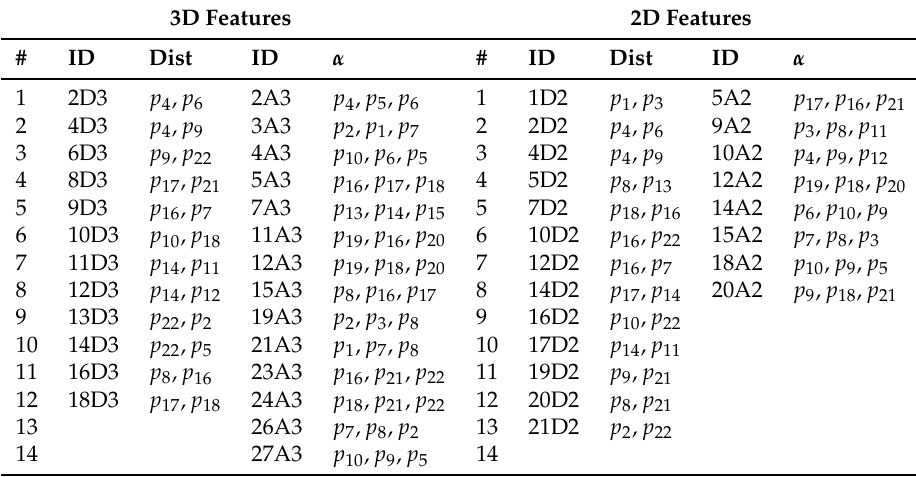
Table 11. 3D and 2D features obtained through a genetic algorithm (GA).